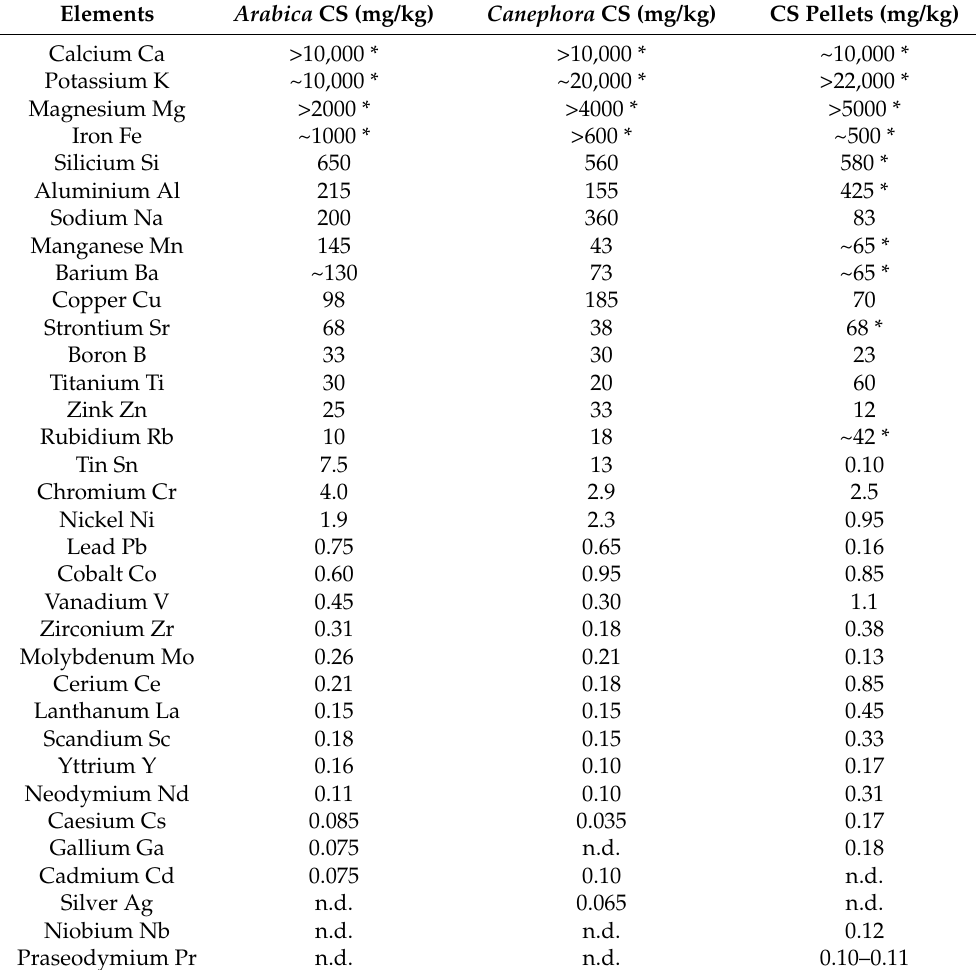
Table 5. Mineral composition of Coffea arabica silver skin ( arabica CS) and Coffea canephora silver skin ( canephora CS) as well as coffee silver skin pellets (CS